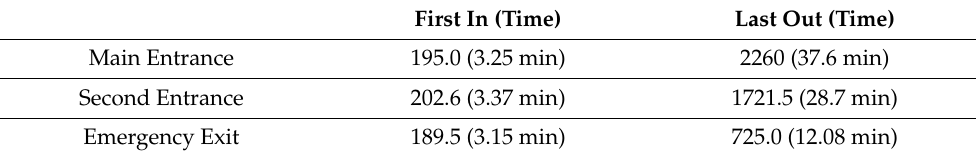
Table 4. Time spent by the first and last occupants through each route for Scenario 1 in Simulation